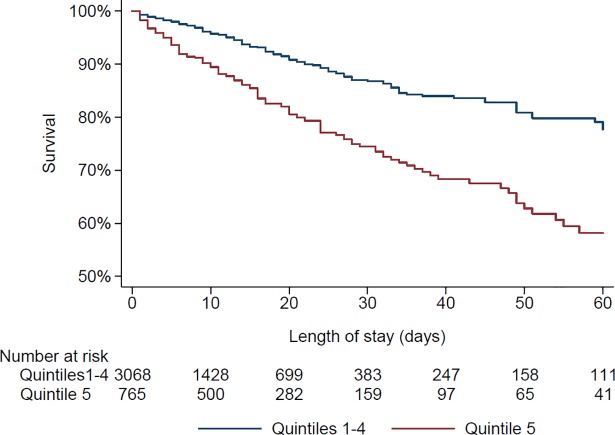
Kaplan-Meyer survival curves according to NT-proBNP level.